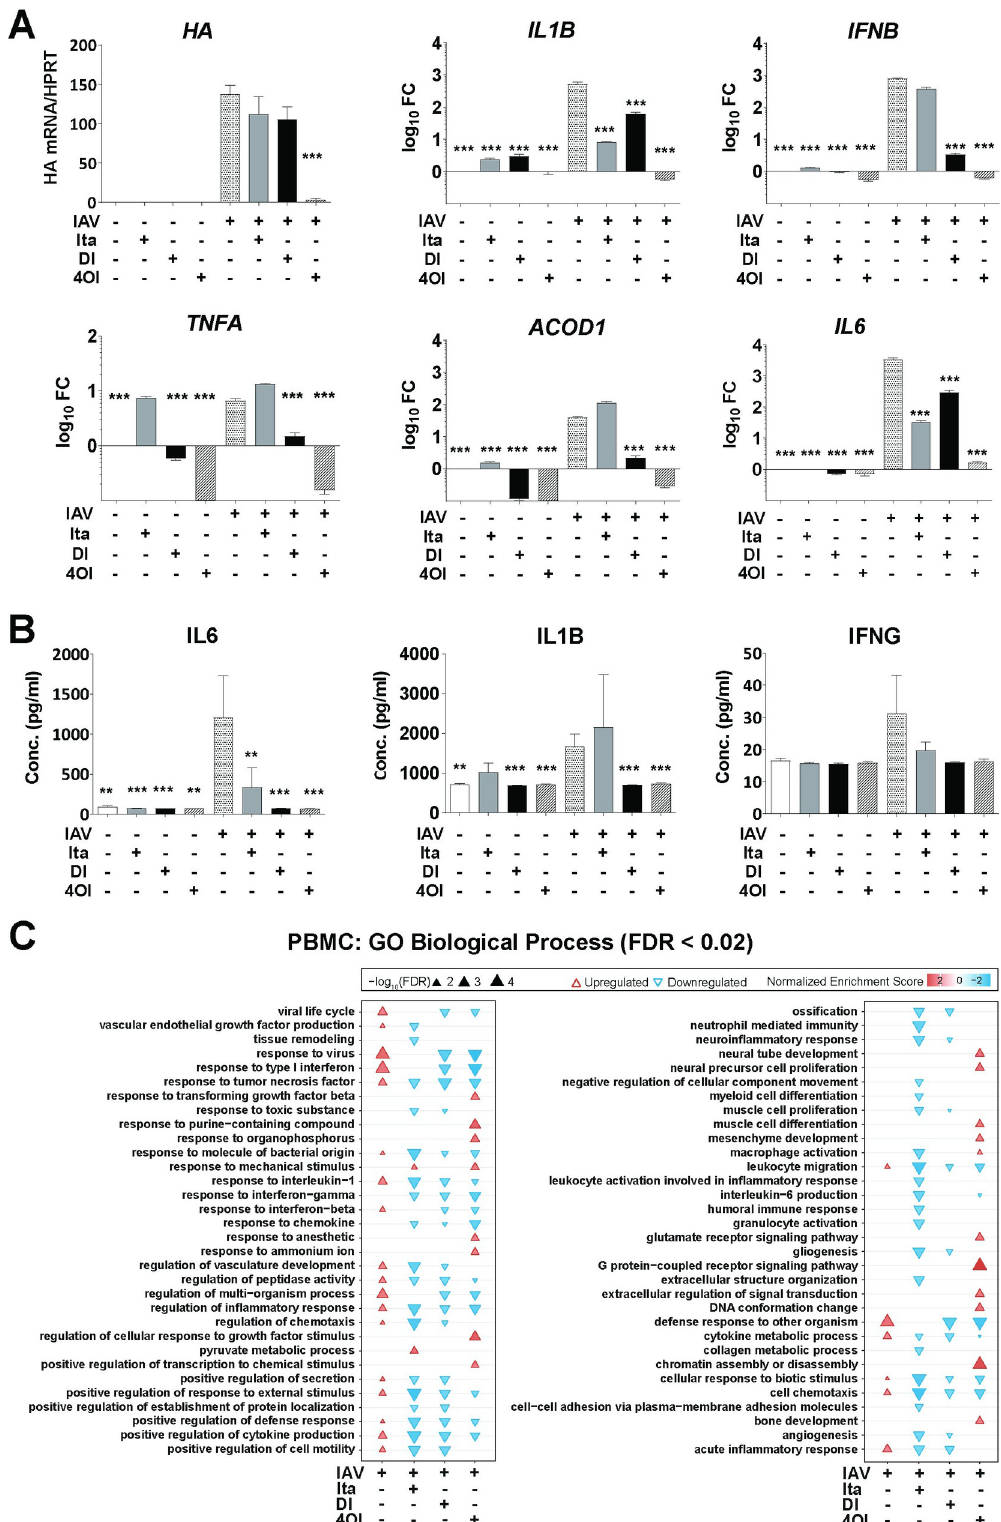
Fig 8. Anti-inflammatory effects of itaconate, DI, and 4OI on IAV-infected human PBMCs. PBMCs were isolated from freshly donated human blood and then infected with IAV (PR8M, MOI = 1) for 12 h in the presence or absence of